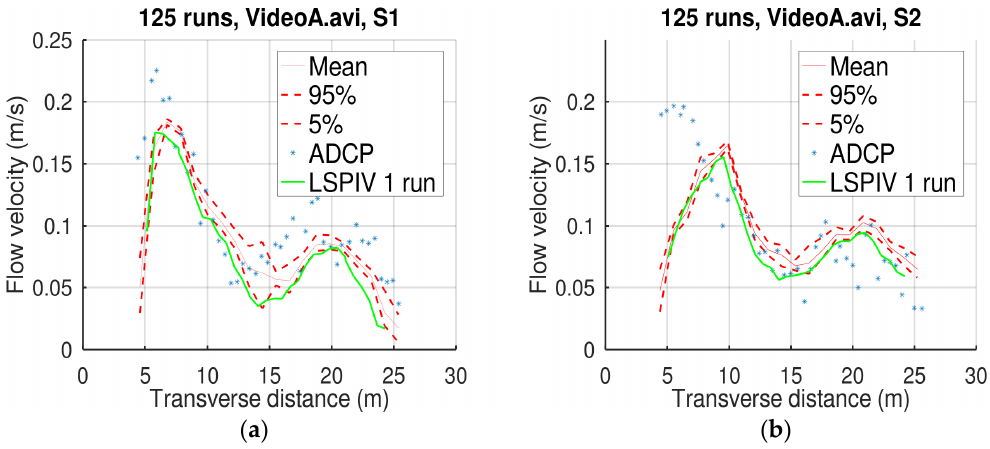
Figure 7. Velocity profiles and measurements for Video A and the cross-sections S1 ( a ) and S2 ( b ).